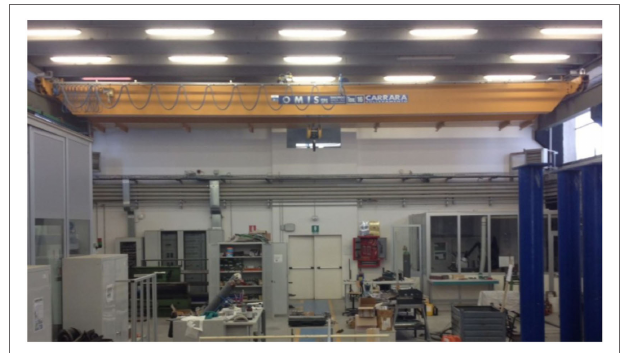
FigUre 1 | Example of overhead crane in precast concrete